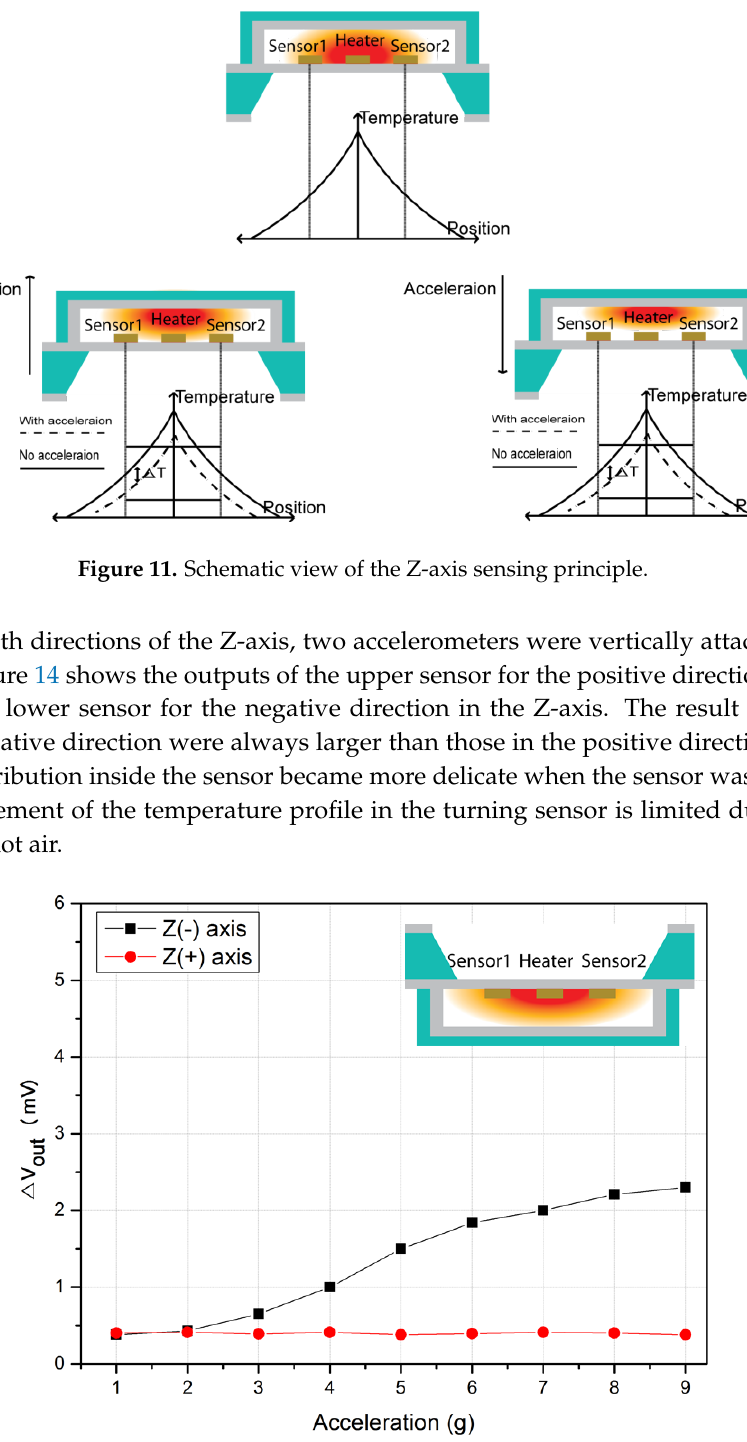
Figure 12. Output characteristic of the accelerometer as a function of the accelerometer on the Z-axis.